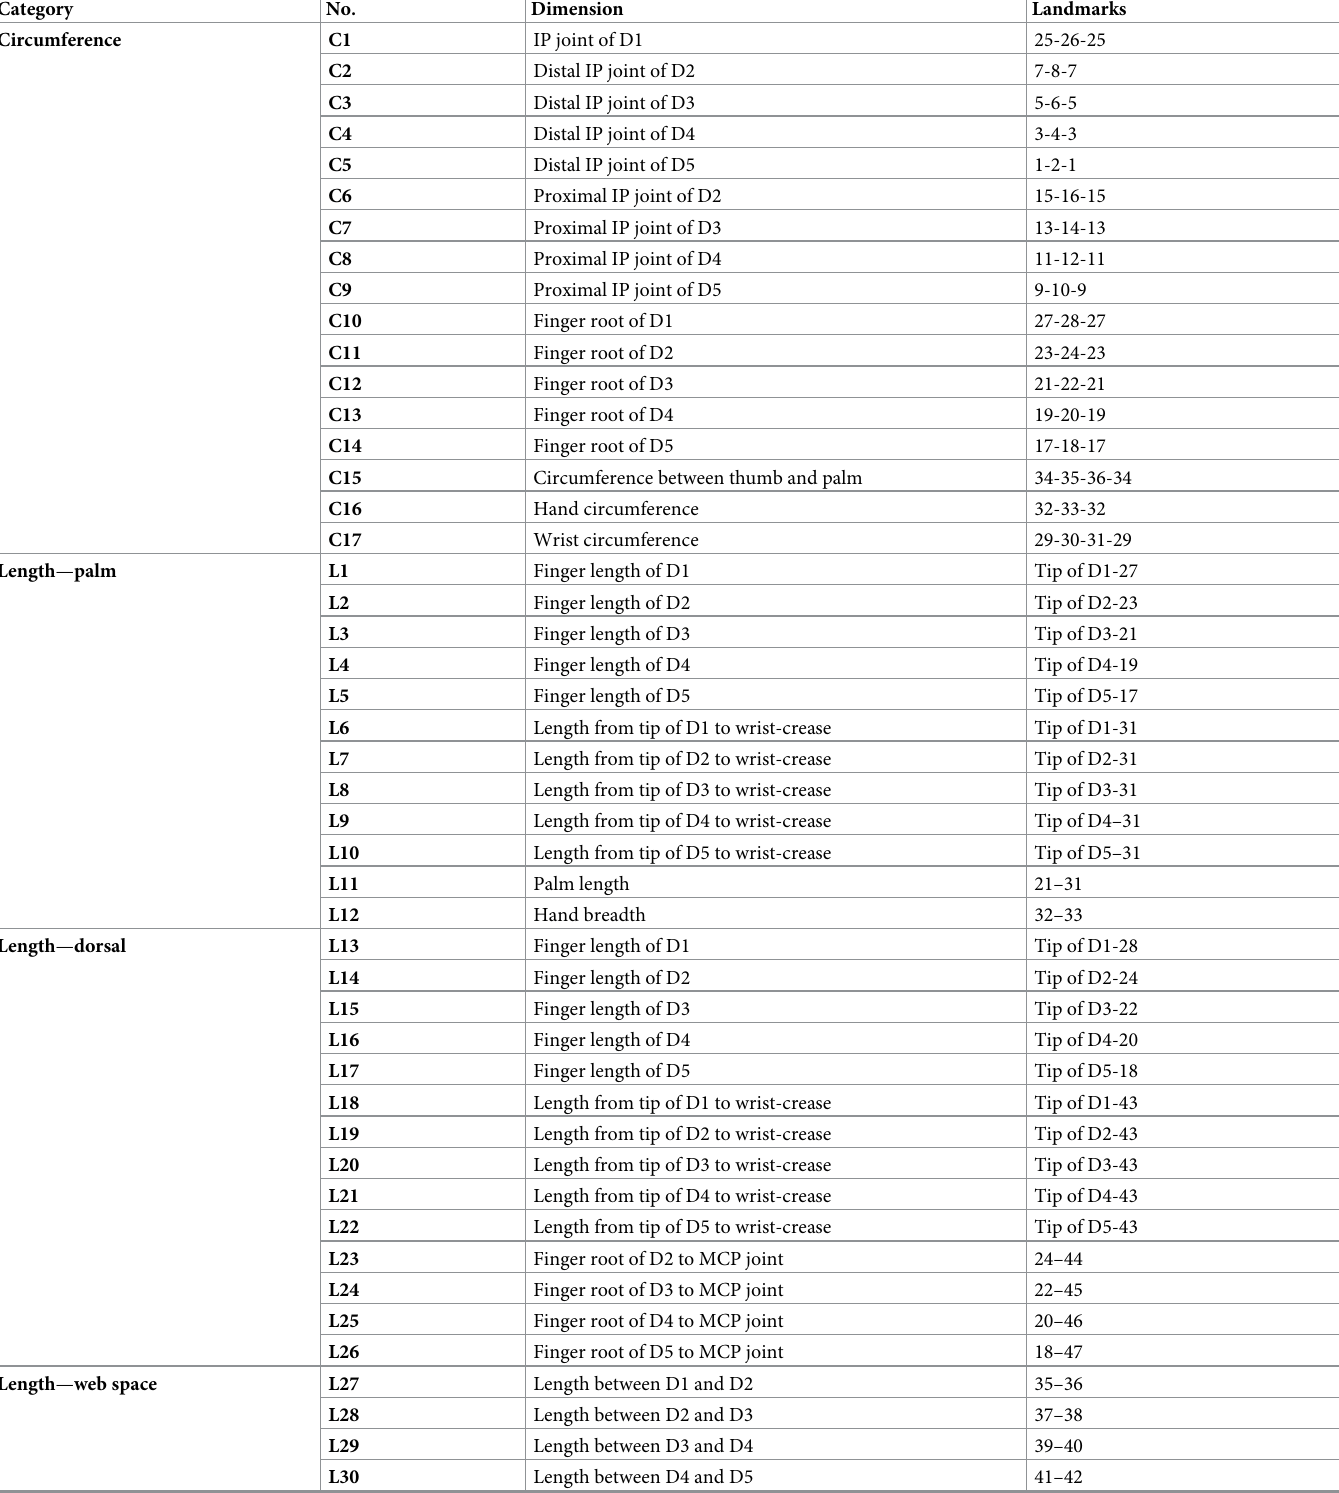
Table 2. Hand measurements for glove